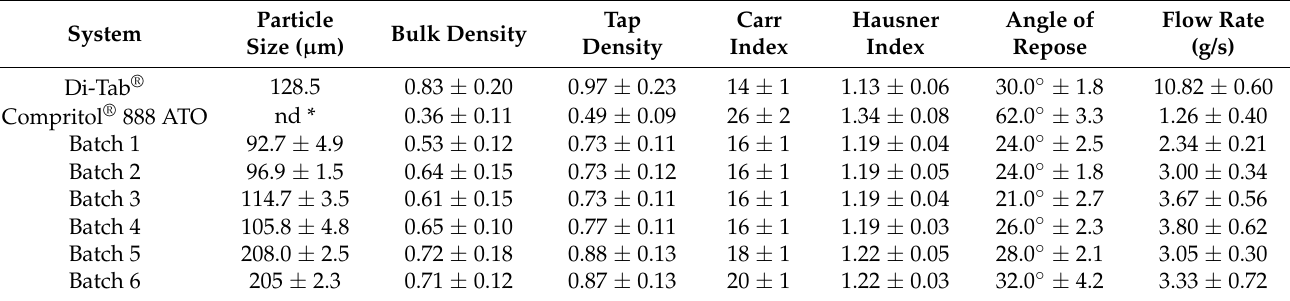
Table 1. Rheological properties and particle size obtained for the co-processed excipients (NLS Compritol ® 888 ATO/ Di-Tab ® )